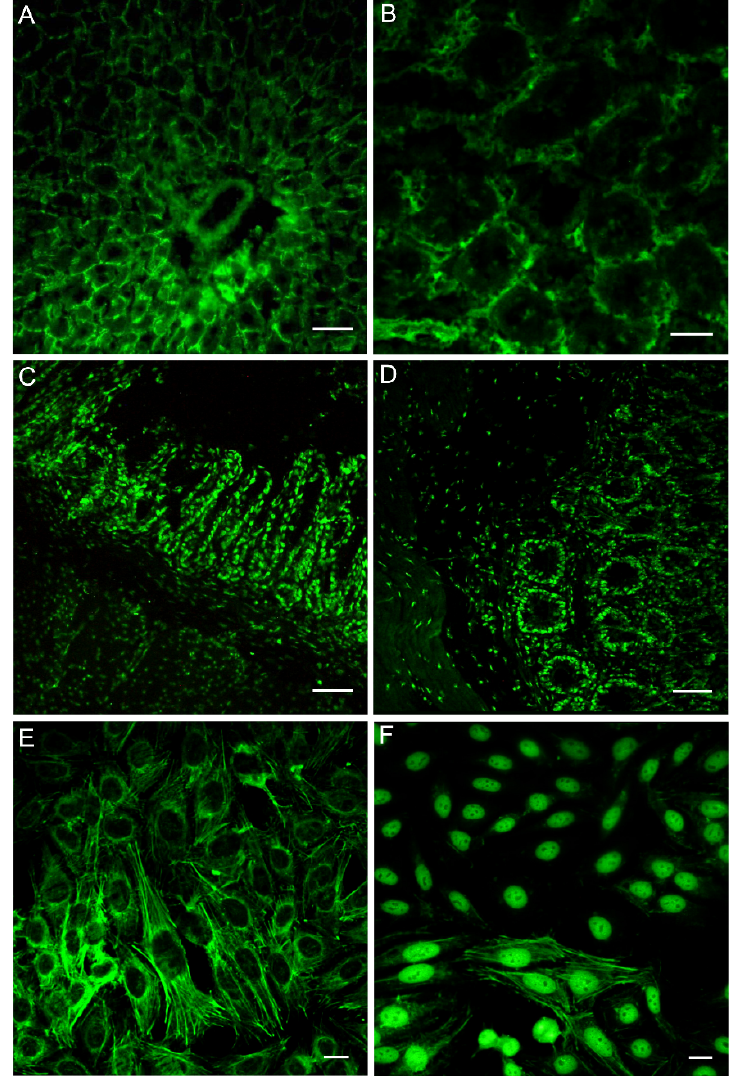
Figure 1. NOSAs, D-ANA and HEp-2 cells immunofluorescence staining patterns of patient with colorectal cancer using an indirect immunofluorescence method. ( A ) Staining surrounding the liver parenchyma, sinusoid, and portal vein was evident using the rat liver substrate. ( B ) Staining of peritubular areas and brush border reactivity was observed using the rat kidney substrate. ( C ) Staining of epithelial cells at nuclear level in the gastric glands and of smooth muscle nuclei was observed using the rat stomach substrate. ( D ) Nuclear staining of epithelial cells into the crypts was very evident as well as the nuclear positivity of the two layers of smooth muscle. ( E ) Representative images of major HEp-2 cell patterns like cytoplasmic fibrillar linear were observed. ( F ) Nuclear dense fine speckled and cytoplasmic fibrillar linear patterns coexisted using the same patient’s serum. Scale bar: ( A , B ) = 30 µm; ( C , D ) = 50 µm; ( E , F ) = 10 µm.